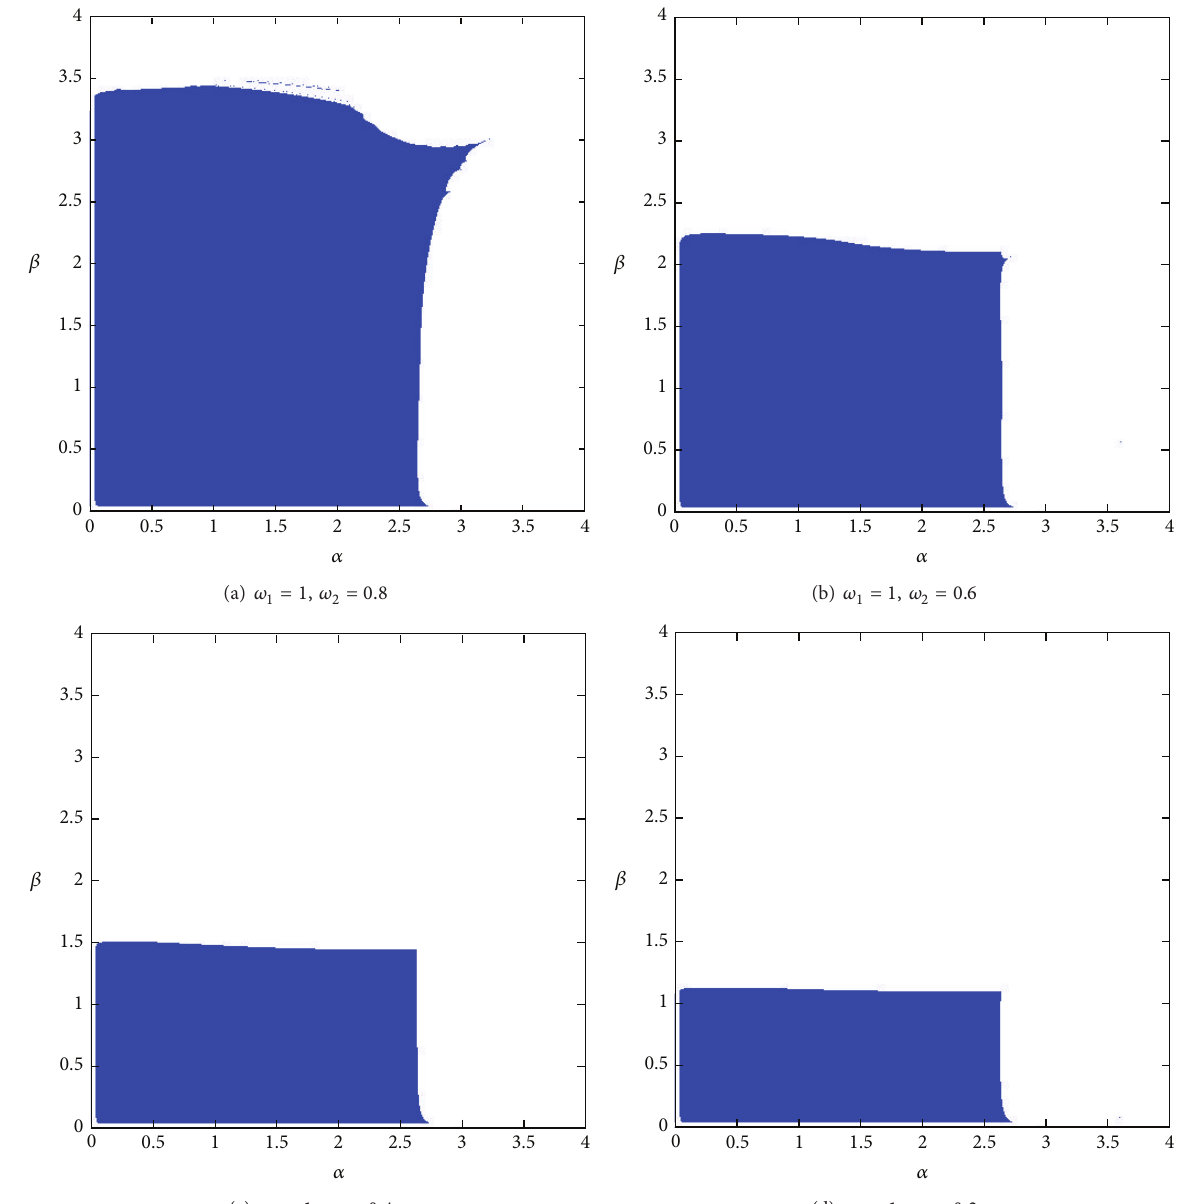
Figure 9: The stability region (dark blue) of the Nash equilibrium point 𝐸 ∗ of system (11) with 𝜔 1 = 1 and 𝜔 2 varying.